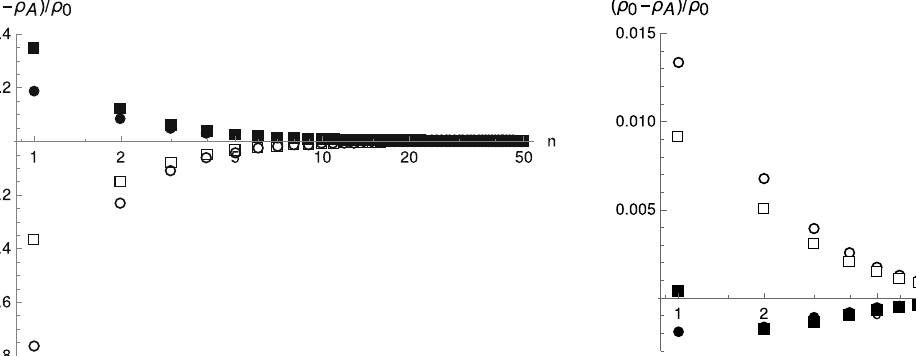
Fig. 3 The discrepancy between the average energy density ρ 0 in the inhomogeneous model and the estimated energy density in the homo- geneous model ρ A for R = 4 M as a function of a number of inhomo- geneous regions. Circles and boxes correspond to different choices of a phase: σ = 1, σ = − 1, respectively. The filled symbols indicate that the outermost shell has higher than ρ 0 density (empty symbols indi- cate otherwise). The value of ρ A was estimated from the observed total mass of cluster constituents M T and the angular diameter distance d A of outermost objects